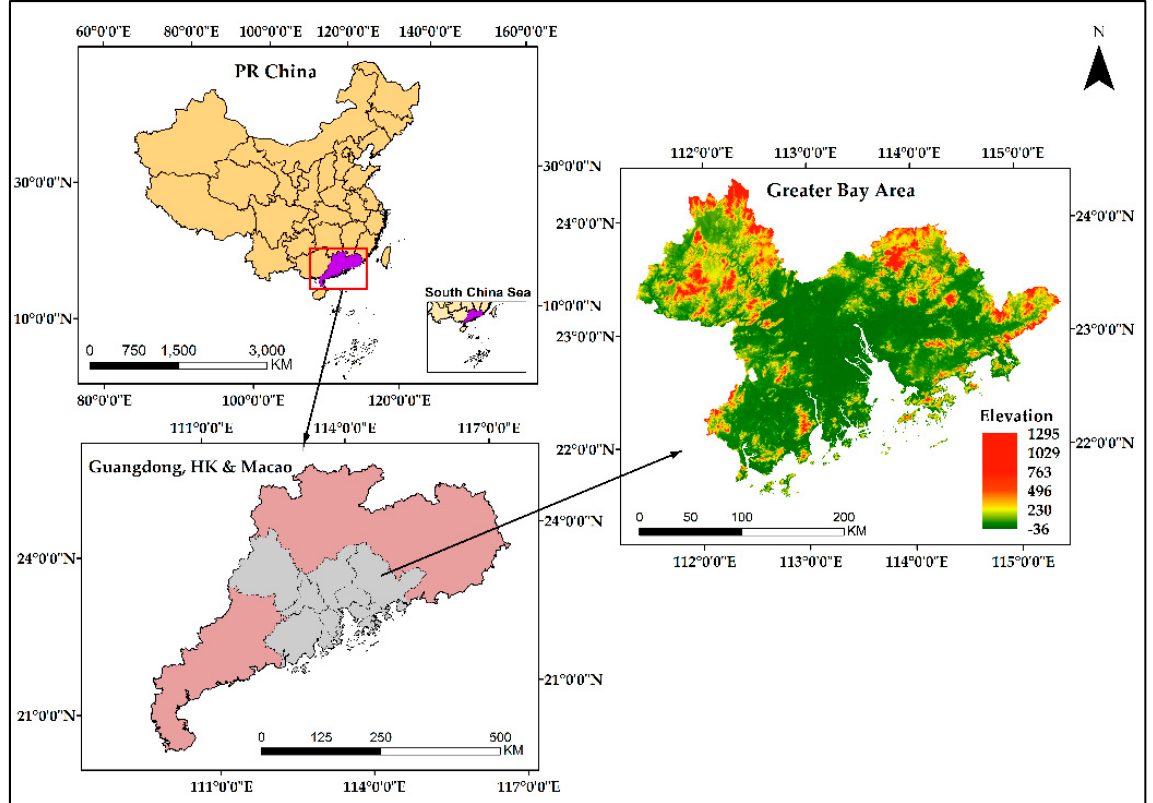
Figure 1. Study Area. Guangdong Hong Kong Macao, Greater Bay Area, China.